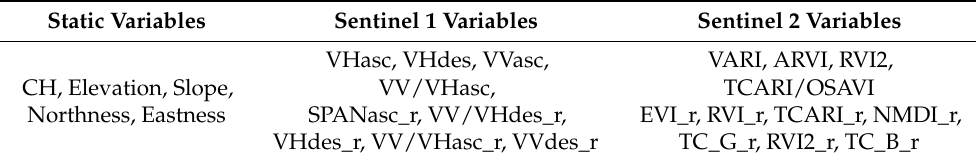
Table 4. Variables selected for LFMC estimation. Variable names as per Table 2. Suffix _r indicates the relative version (on separate lines) of the variable.